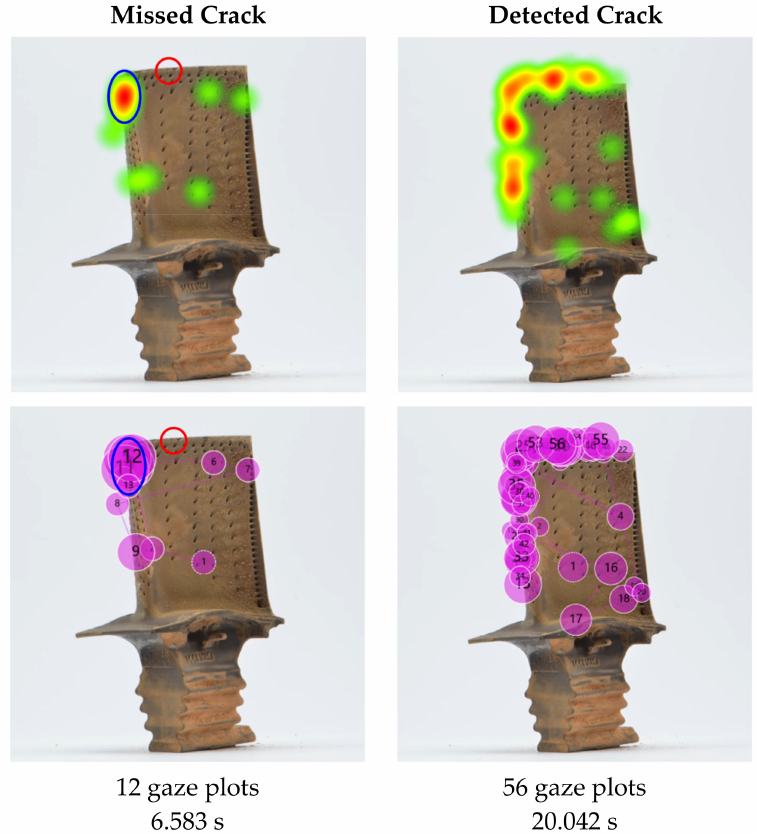
Figure 19. A blade with a crack (red circle) and burn (blue circle) was presented to participants. Heat maps and gaze plots were created for a missed crack ( left ) and a detected crack ( right